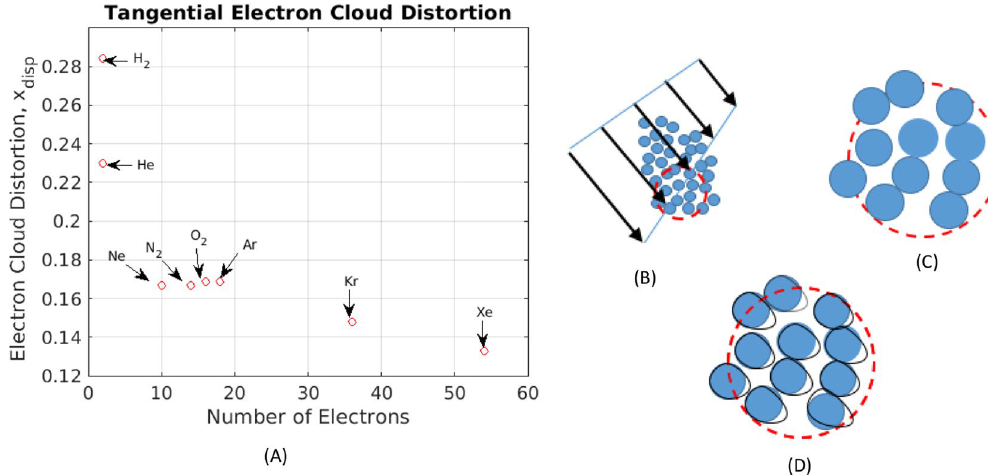
Figure 7. Distortion of electron clouds appears to play a dominant role in both emergence of single- molecule-scale viscosity and resistive viscous forces, as well as in repulsion-driven single molecule hopping. Intuitively, we anticipate that the magnitudes of cloud distortion associated with each process, δσ disp and δσ diff , respectively, should be roughly of the same magnitude. In order to test this idea, and as a consistency check on the proposed models of dispersion-induced viscosity generation and phonon-induced self-diffusion, we estimate viscosity-generating cloud distortion, δσ disp , using an expression equivalent to (8) for the polarization 41 : 2 /( 9 a 4 n , where n is the number of electrons in the molecule, and α / is the mean squared collision- r 2 1 r 2 1 o ) = � � (cid:31) (cid:30) induced displacement of any of the (indistinguishable) electrons occupying the first shell of the molecule. Labeling the quartic root of the latter as δσ disp , and identifying this as the characteristic tangential cloud δσ disp /σ . As shown in ( A ), outside of He distortion, we calculate the relative tangential distortion as: x disp = and H 2 - which, due to small masses, are apparently dominated by quantum collision dynamics - estimated tangential cloud distortions are approximately of the same magnitiude as those producing self-diffusion, Fig. 6. Thus, while cloud distortions are of comparable magnitude, the type of distortion, compressive versus shearing, engages repulsive versus attractive intermolecular forces. Plate ( B ) highlights the essential role of microscale (long-time-averaged) shear stresses in driving tangential cloud distortion and resulting viscosity generation. Plate ( C ) depicts liquid state molecules under local equilibrium conditions (sans phonon jitter). Nonequilibrium, shear-driven, tangential cloud distortion appears as small white areas at the edge of each molecule in Plate ( D ).